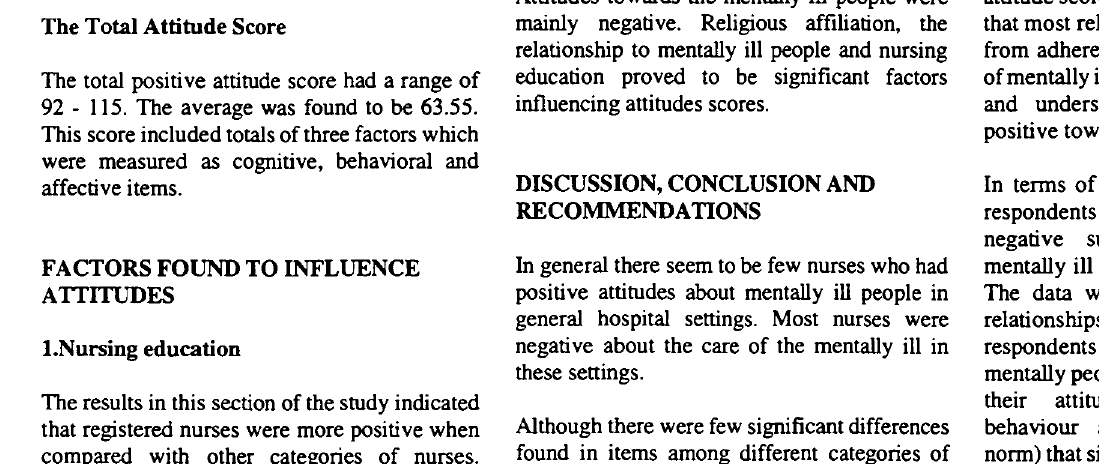
TABLE 7 : ITEMS ON WHICH DIFFERENT CATEGORIES OF NURSES GAVE SIGNIFICANTLY DIFFERENT ANSWERS Most mentally ill people are